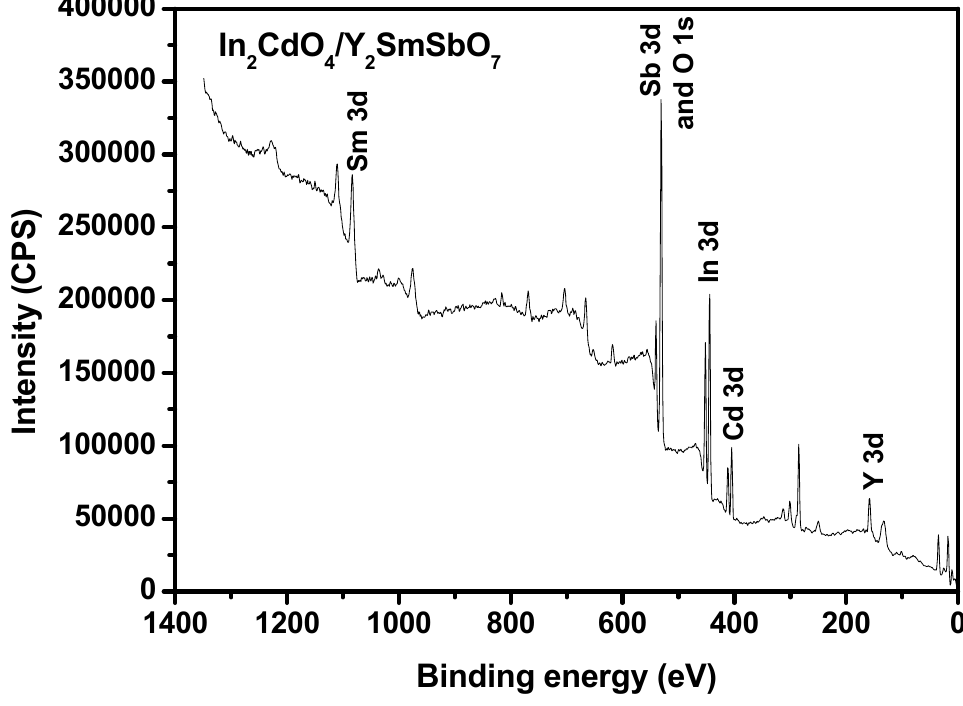
Figure 7. XPS survey spectrum of the In 2 CdO 4 /Y 2 SmSbO 7 heterojunction.